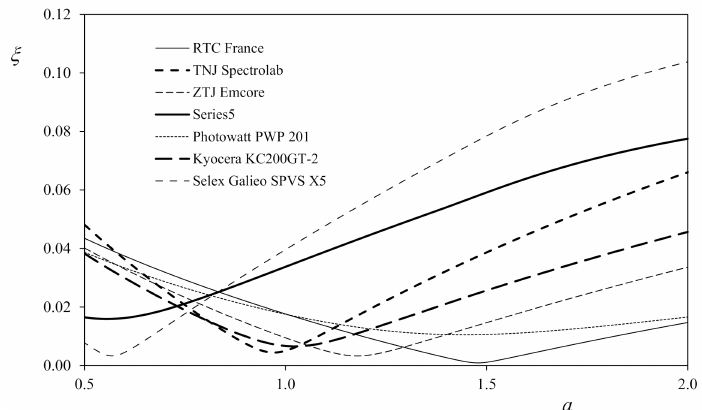
Figure 5. Non-dimensional RMSE, ξ , corresponding to the analytical approximations for extracting the 1-D/2-R equivalent circuit parameters in relation to the ideality factor, a , selected, for each one of the analyzed solar cells and panels. Table 3. Parameters of the 1-D/2-R equivalent circuit models analytically fitted to I-V curves corresponding to data from RTC France, TNJ Spectrolab, ZTJ Emcore, and Azrur Space 3G30C solar cells, and Photowatt PWP 201, Kyocera KC200GT-2, and Selex Galileo SPVS X5 solar panels (where ξ is the non-dimensional RMSE for the fit). Solar